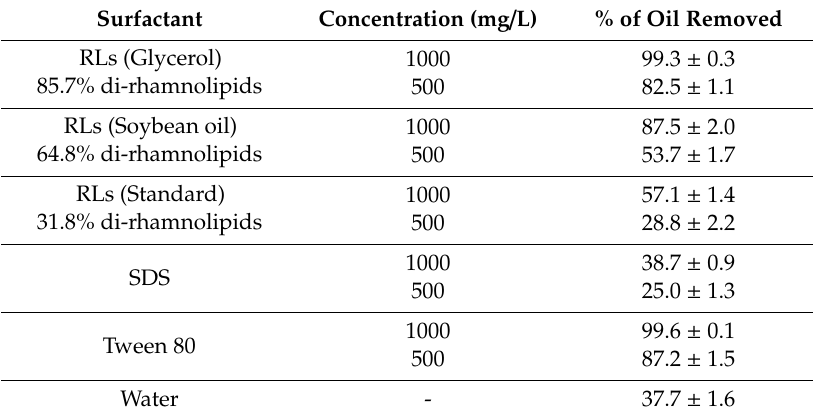
Table 4. Oil-washing e ffi ciency of surfactant